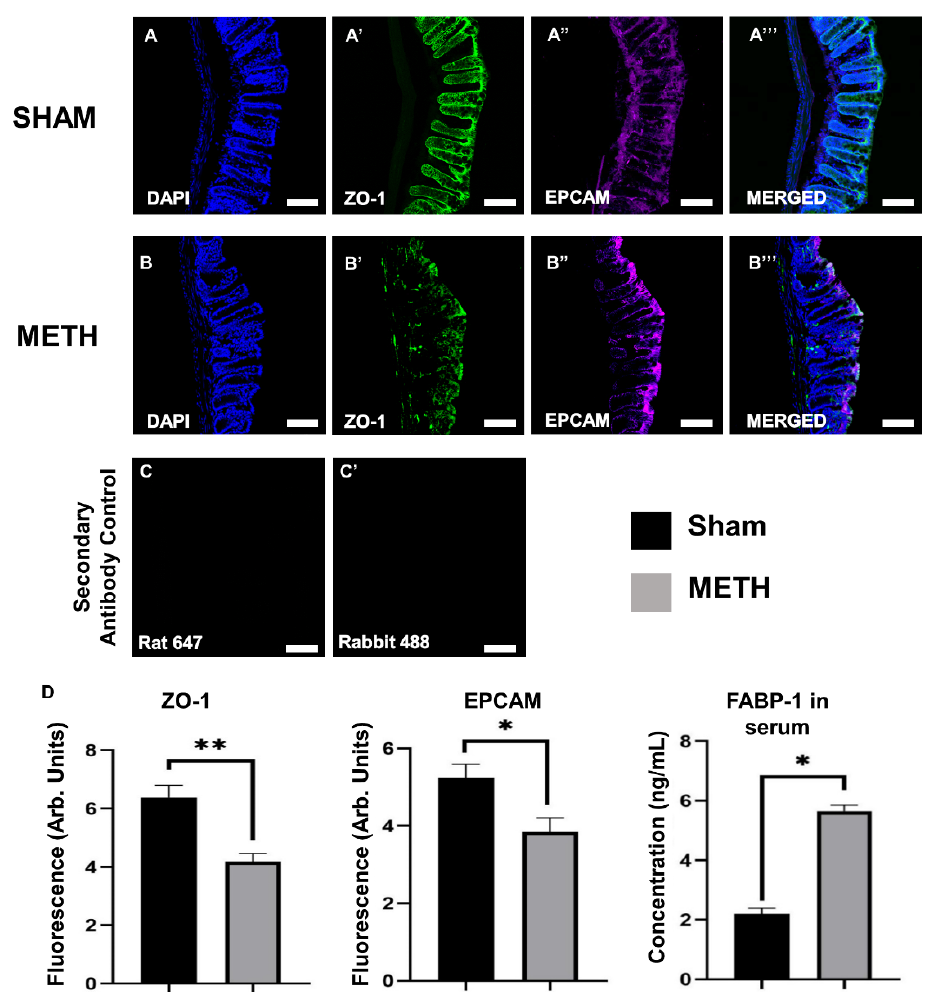
Figure 2. Acute METH exposure increases permeability within the colon. Colon cross-sections of sham-treated ( A , A’ , A” , A”’ ) and METH-treated ( B , B’ , B” , B”’ ) mice. ( A , B ) DAPI nuclei staining, ( A’ , B’ ) tight junction proteins labeled with anti- zonula occludents-1 (ZO-1) antibody, ( A” , B” ) epithelial cells labeled with anti-epithelial cell adhesion molecule (EpCAm) antibody, and ( A”’ , B”’ ) merged images of DAPI, ZO-1, and EpCAm. ( C , C’ ) Secondary Antibody Control. To show the non-specific binding of the secondary antibody, the primary antibody was omitted. Colon cross-sections; 20 μm. Images captured at 40×, scale bar: 50 μm. ( D ) Significant differences between sham-treated and METH-treated mice in tight junction permeability, epithelial cells, and concentration of fatty acid-binding protein (FABP)-1 in serum are shown. Results are expressed as mean ± standard error of the mean (SEM), * p < 0.05, ** p < 0.01.